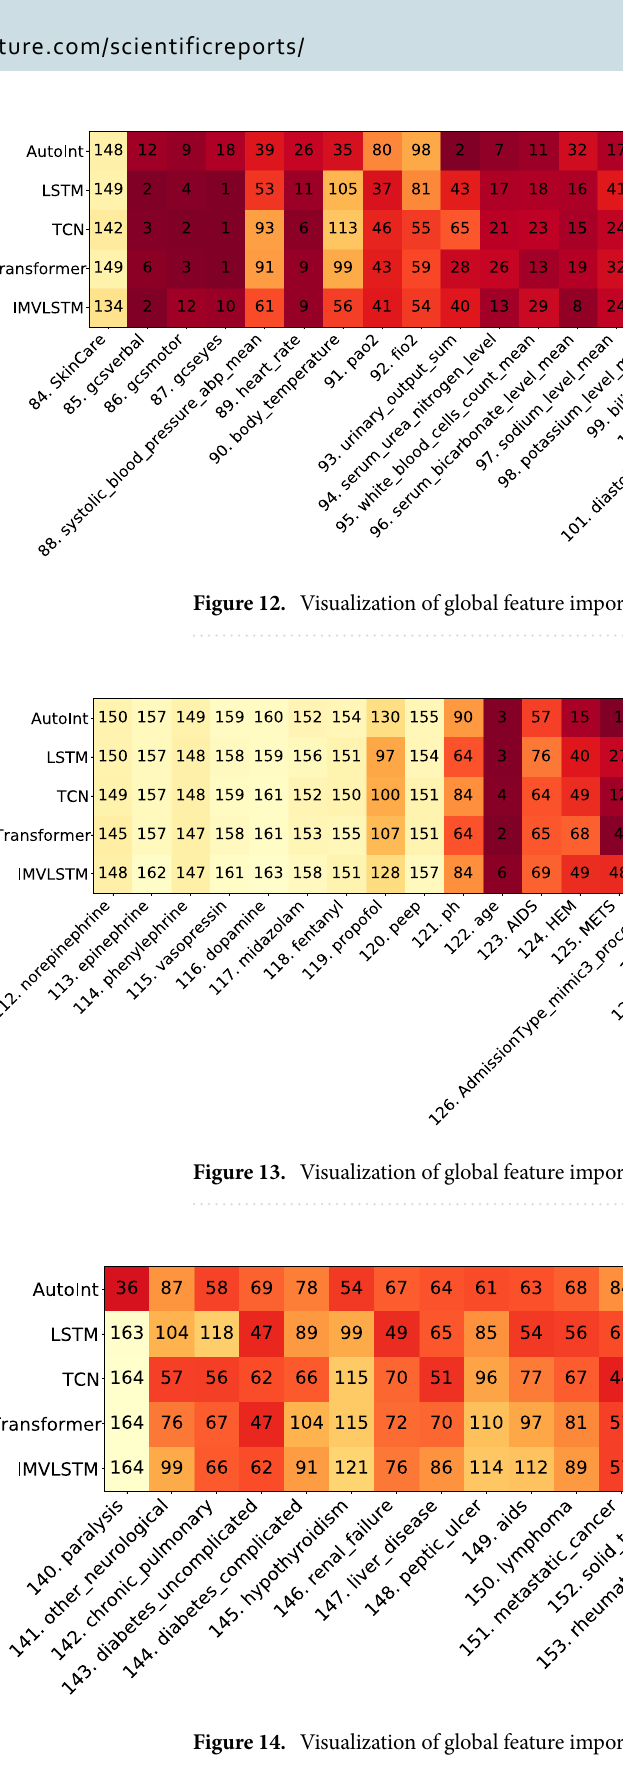
Figure 14. Visualization of global feature importance ranks (feature